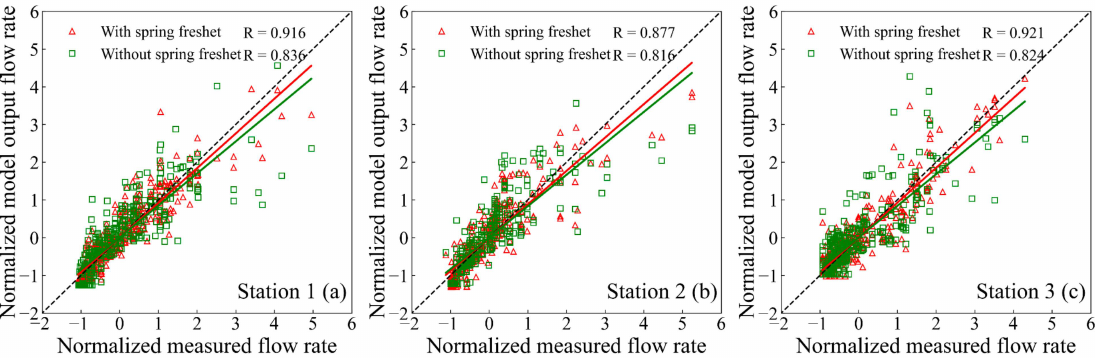
Figure 5. Correlations between the predicted and the observed flow rates (both standardized) with and without spring freshet as an input to the flow rate model. ( a ) Station 1; ( b ) Station 2; ( c ) Station 3.